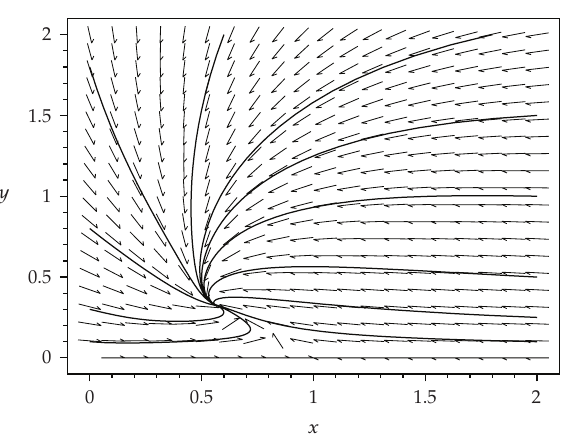
Figure 3: Topological structure of system (cid:5) 3.1 (cid:6) at (cid:5) b/d, 0 (cid:6) and (cid:5) x ∗ ,y ∗ (cid:6) when R 0 > 1, where b (cid:7) 1 , d (cid:7) 1 , k (cid:7) 2 , γ (cid:7) 0 . 5 , α (cid:7) 1 , μ (cid:7) 0 . 5.